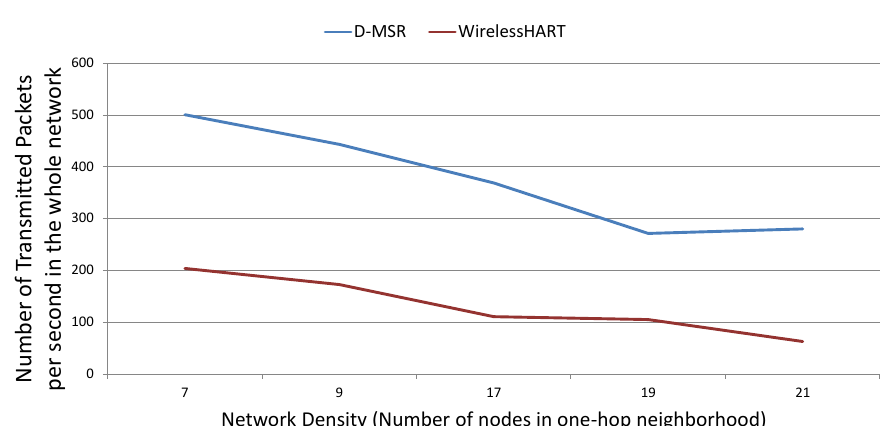
Figure 23. Network throughput (D-MSR vs.